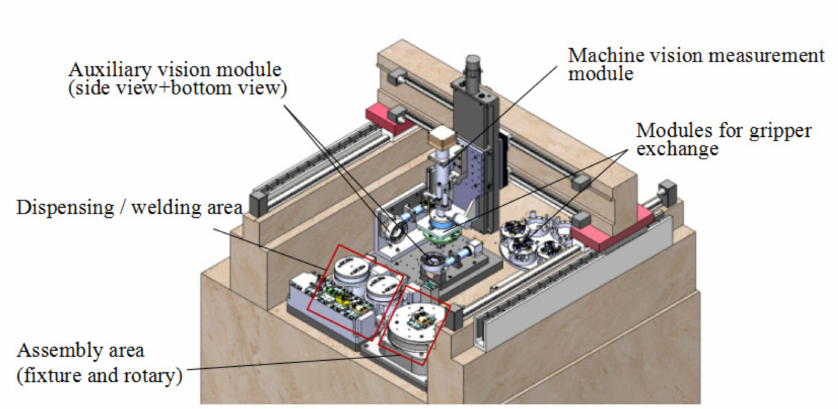
Figure 2. Layout of the